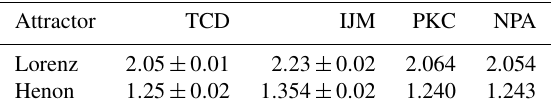
Table 1. Comparison of the correlation dimensions derived from different methods. TCD: theoretical correlation dimension; IJM: in- tuitive judgment method; PKC: point-based K -means clustering; NPA: newly proposed